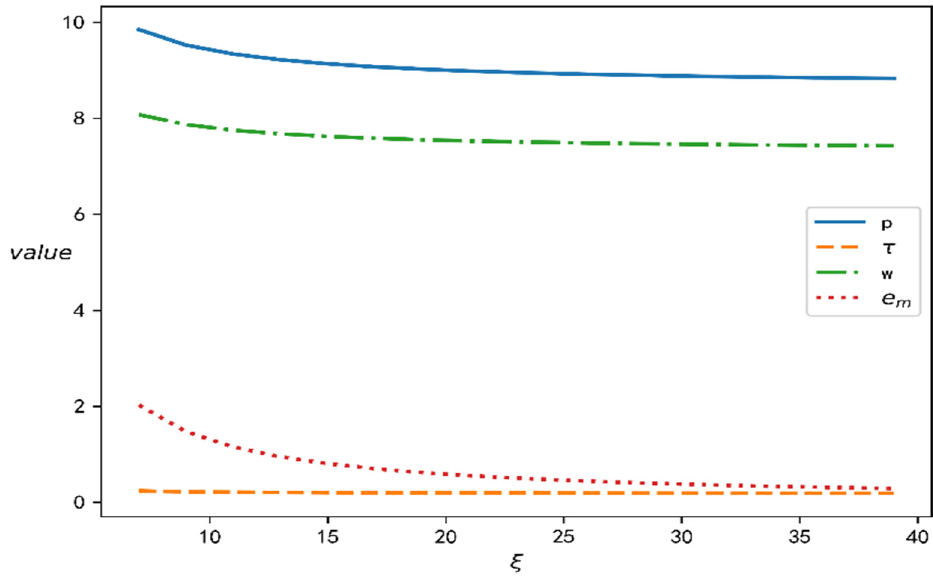
Figure 6. The influence of the parameter ξ on decision variables of closed-loop supply